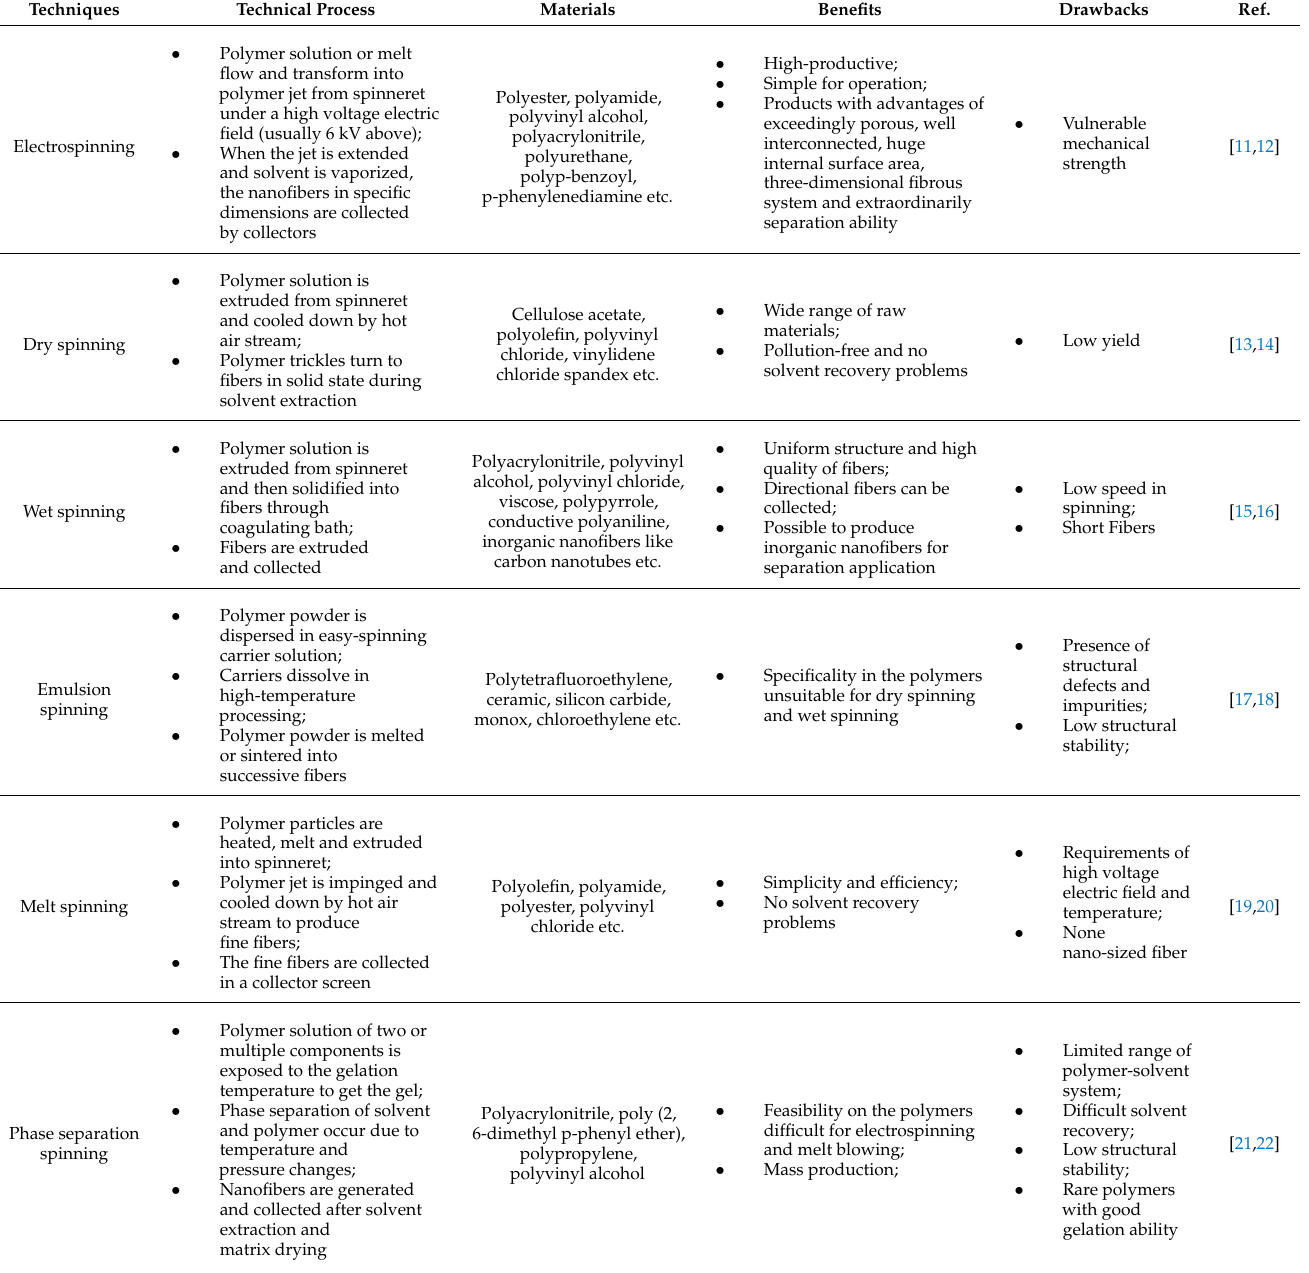
Table 1. Comparison of different fabrication techniques of